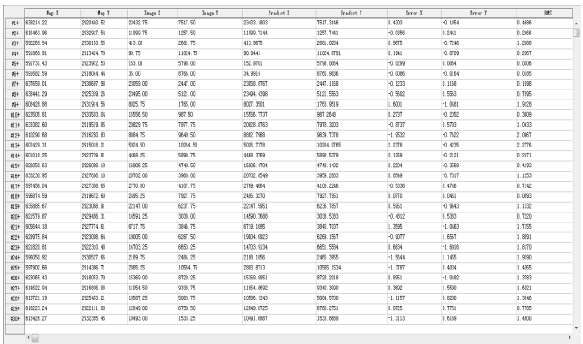
Figure 5. RMS of selected control points